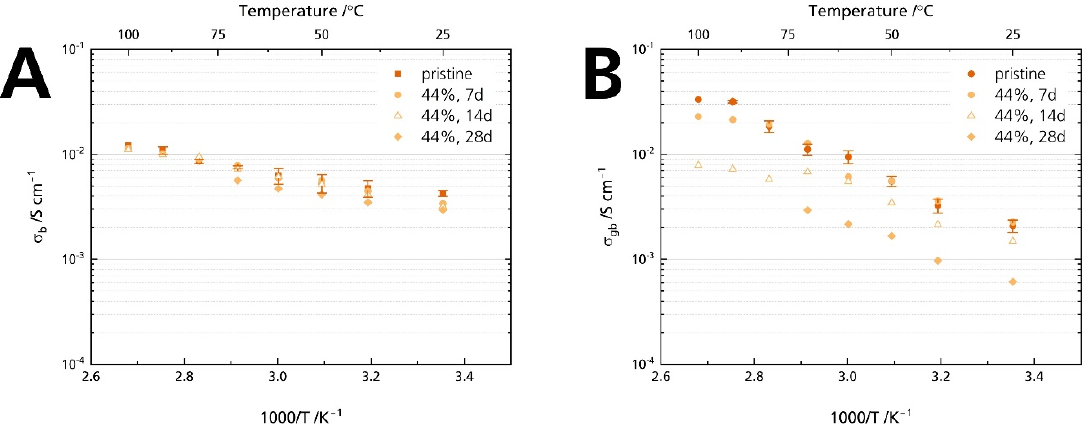
Figure 10. Development of the conductivities after storage times of 7, 14, and 28 days for the samples stored in 44% r.h.: ( A ) bulk and ( B ) grain boundary conductivity. The error bars represent standard deviations.